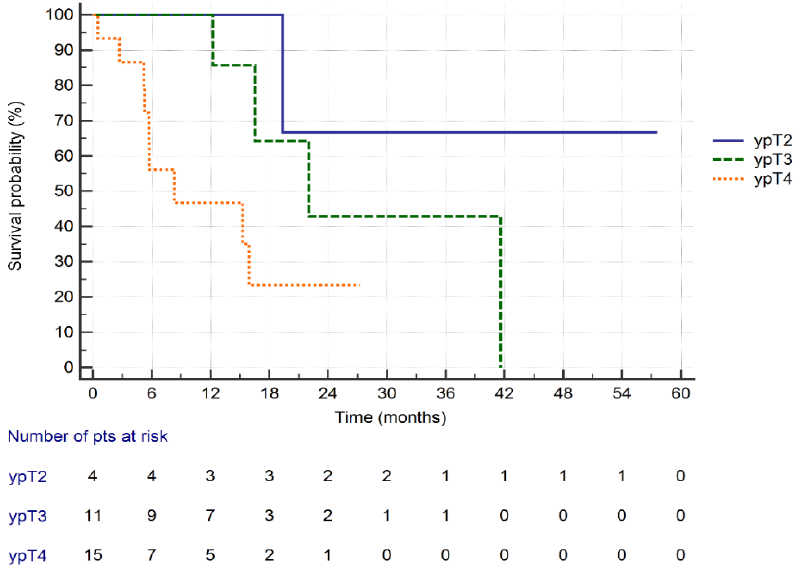
Figure 5. Overall survival of GC patients treated with CRS + HIPEC depending on the ypT feature ( p = 0.03; log-rank test).